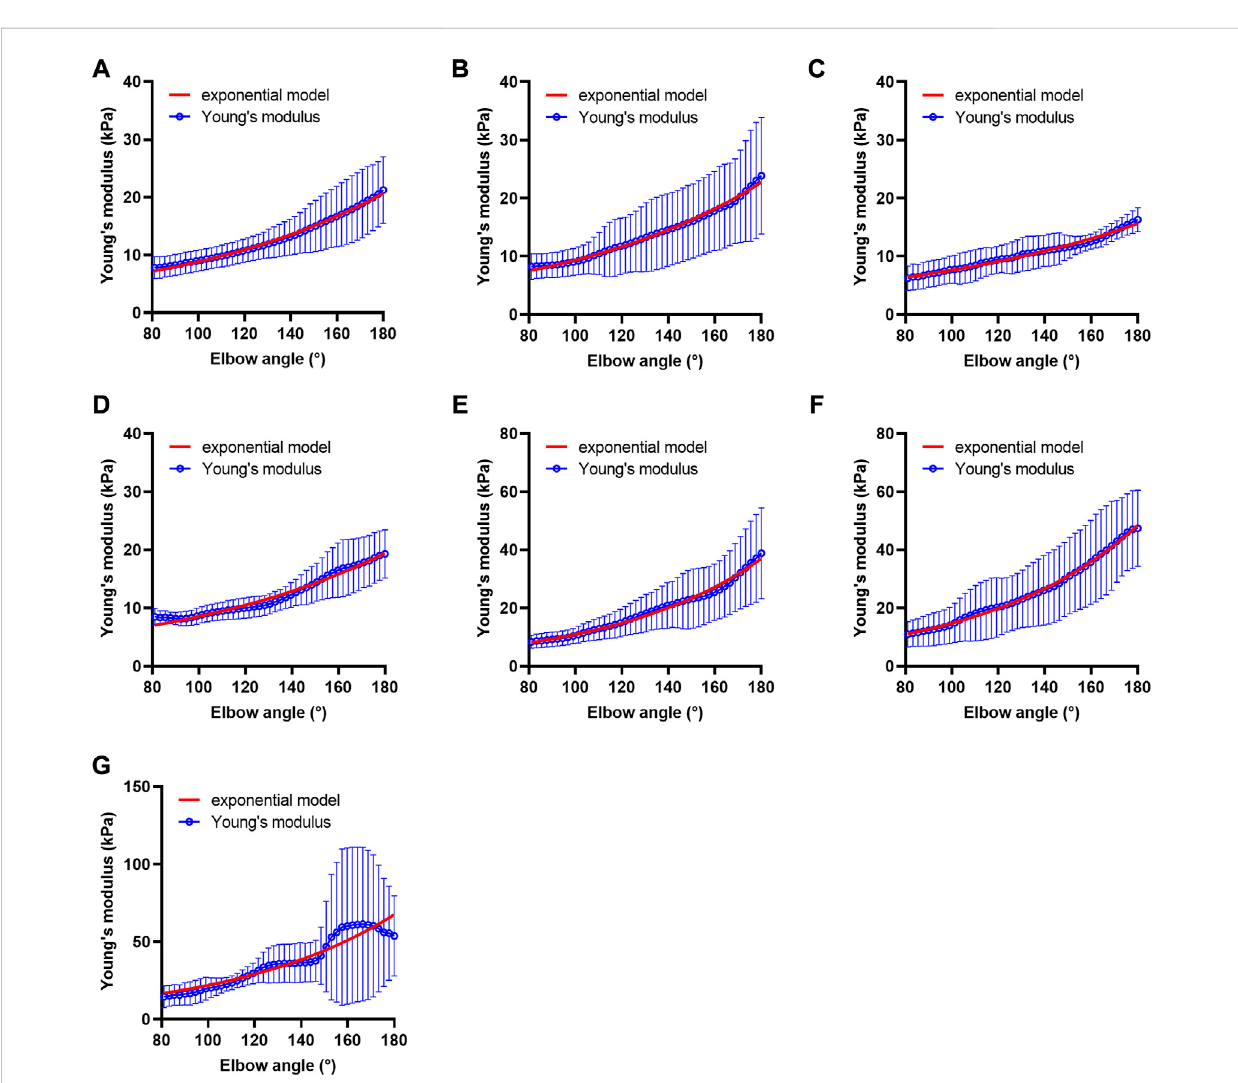
FIGURE 4 Fitted curves of Young ’ s modulus of each group. (A) Fitted curve of thehealthy volunteer group, n = 52, (B) fi tted curve of theunaffected side of the patientgroup, n =43, (C) fi ttedcurveofthehypotoniagroup, n =4, (D) fi ttedcurveoftheMAS0group, n =9, (E) fi ttedcurveoftheMAS1group, n =22, (F) fi ttedcurveoftheMAS1+group, n =10,and (G) fi ttedcurveoftheMAS2group, n =4.AlphavalueofMAS1,MAS1+,andMAS2groupsishigherthanthat of HG, UG, hypotonia group, and MAS 0 group. Abbreviations: HG, healthy volunteer group; MAS, modi fi ed Ashworth scale; UG, unaffected side of patient